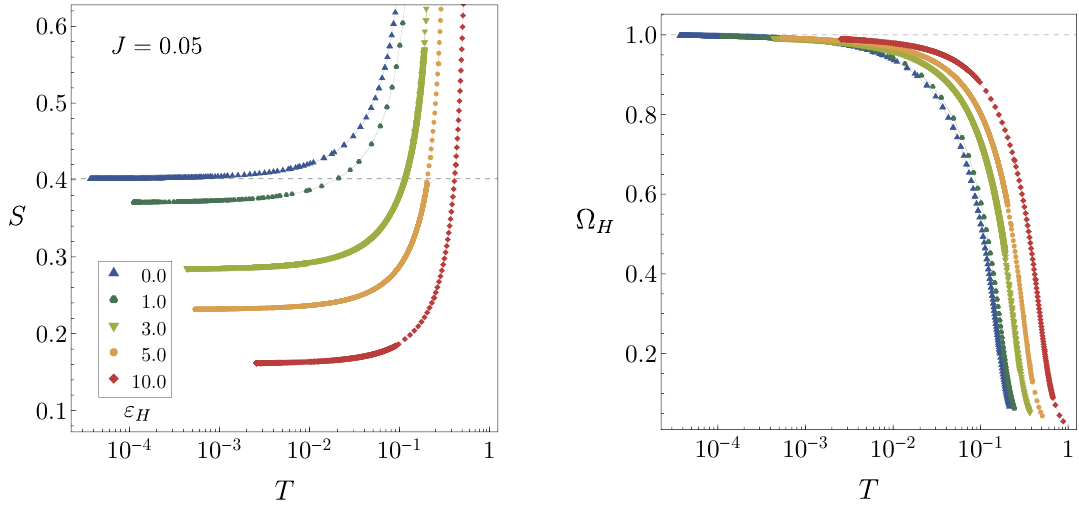
Figure 7 . Log-linear plot of the entropy ( left ) and the horizon angular velocity ( right , the legend is the same as for S ) of the hairy solutions with (cid:12)xed angular momentum J = 0 : 05 against the temperature, for several values of the horizon scalar " H . The horizontal dashed gridline shows the values for the supersymmetric black hole with the same J .